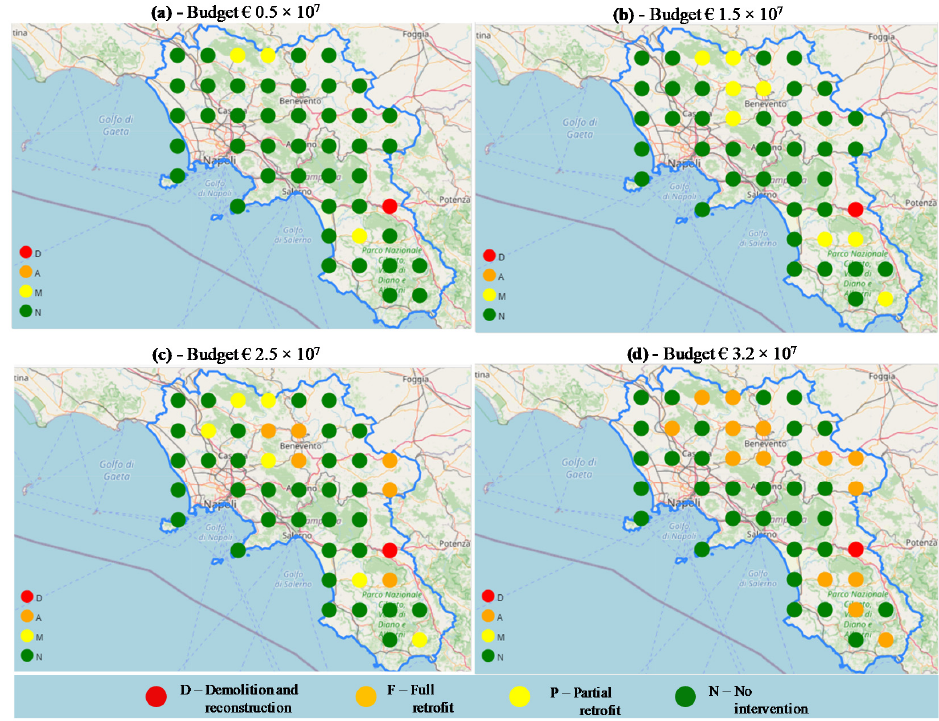
Figure 14. Decision strategies for budget value of: EUR 0.5 × 10 7 ( a ), EUR 1.5 × 10 7 ( b ), EUR 2.5 × 10 7 ( c ) and EUR 3.2 × 10 7 ( d ).